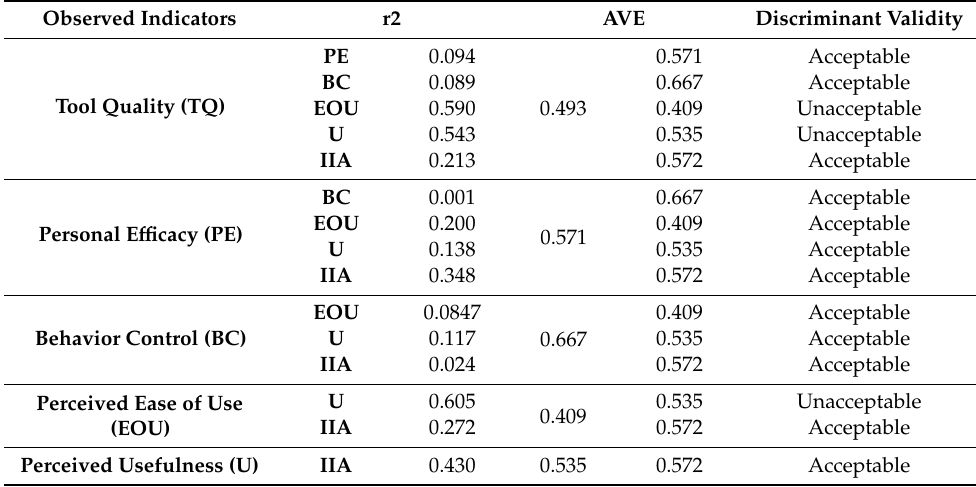
Table 10. Results of discriminant validity